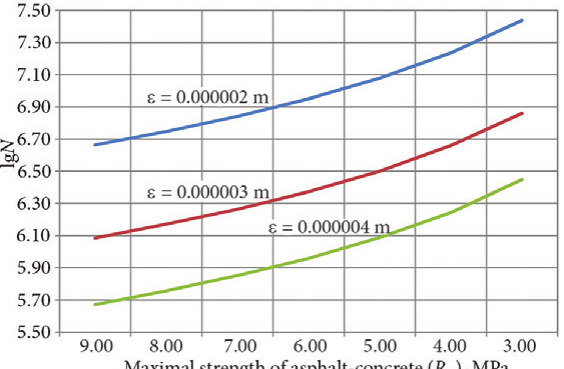
Fig. 4. Durability of asphalt concrete under cyclic continues stress